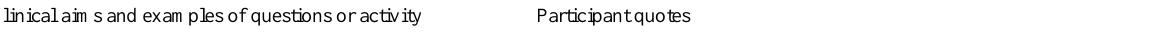
Table 3. Understanding user perspectives and experiences of participants on the clinical aims using the mobile food record app and their experiences or views about using a physical activity